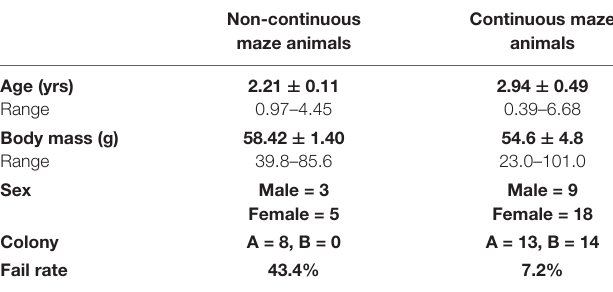
TABLE 1 | Descriptive statistics (values shown are mean ± SEM, and range) for naked mole-rats used across two different spatial maze designs. Non-continuous Continuous maze maze animals